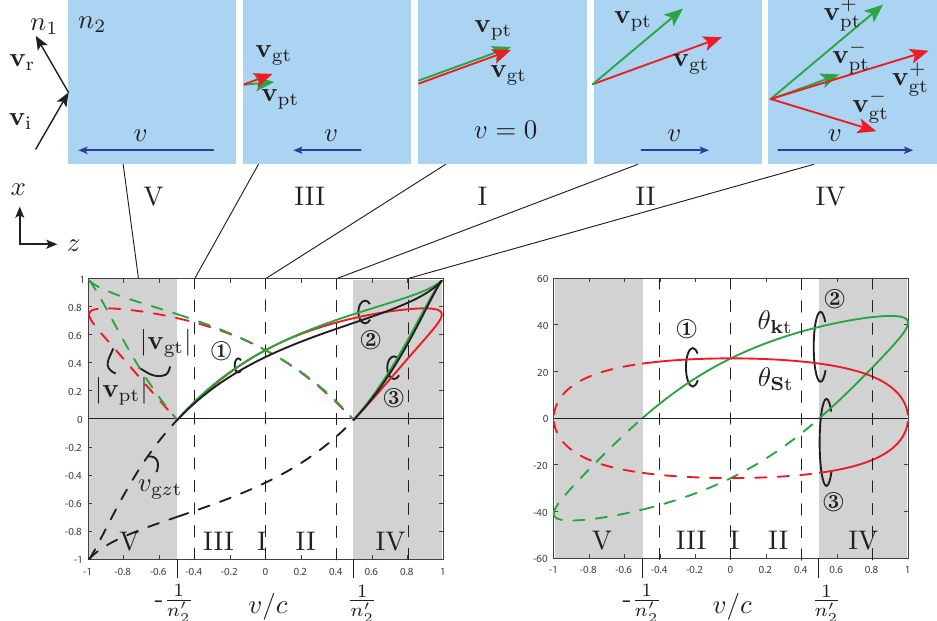
= 1, and n (cid:48) = 2. 2 1